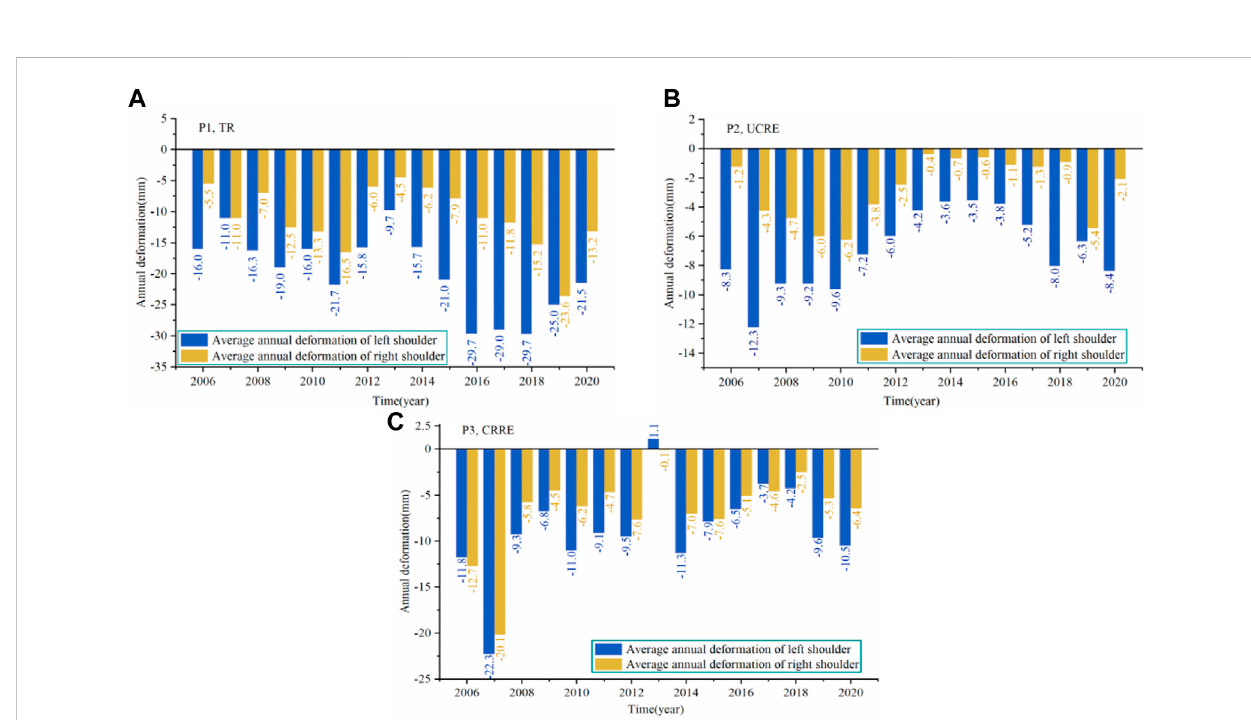
171 mm, with an average value of 127 mm, and the cumulative settlement value of the right shoulder was between 58 and 131 mm, with an average value of 94 mm, and the cumulative settlement